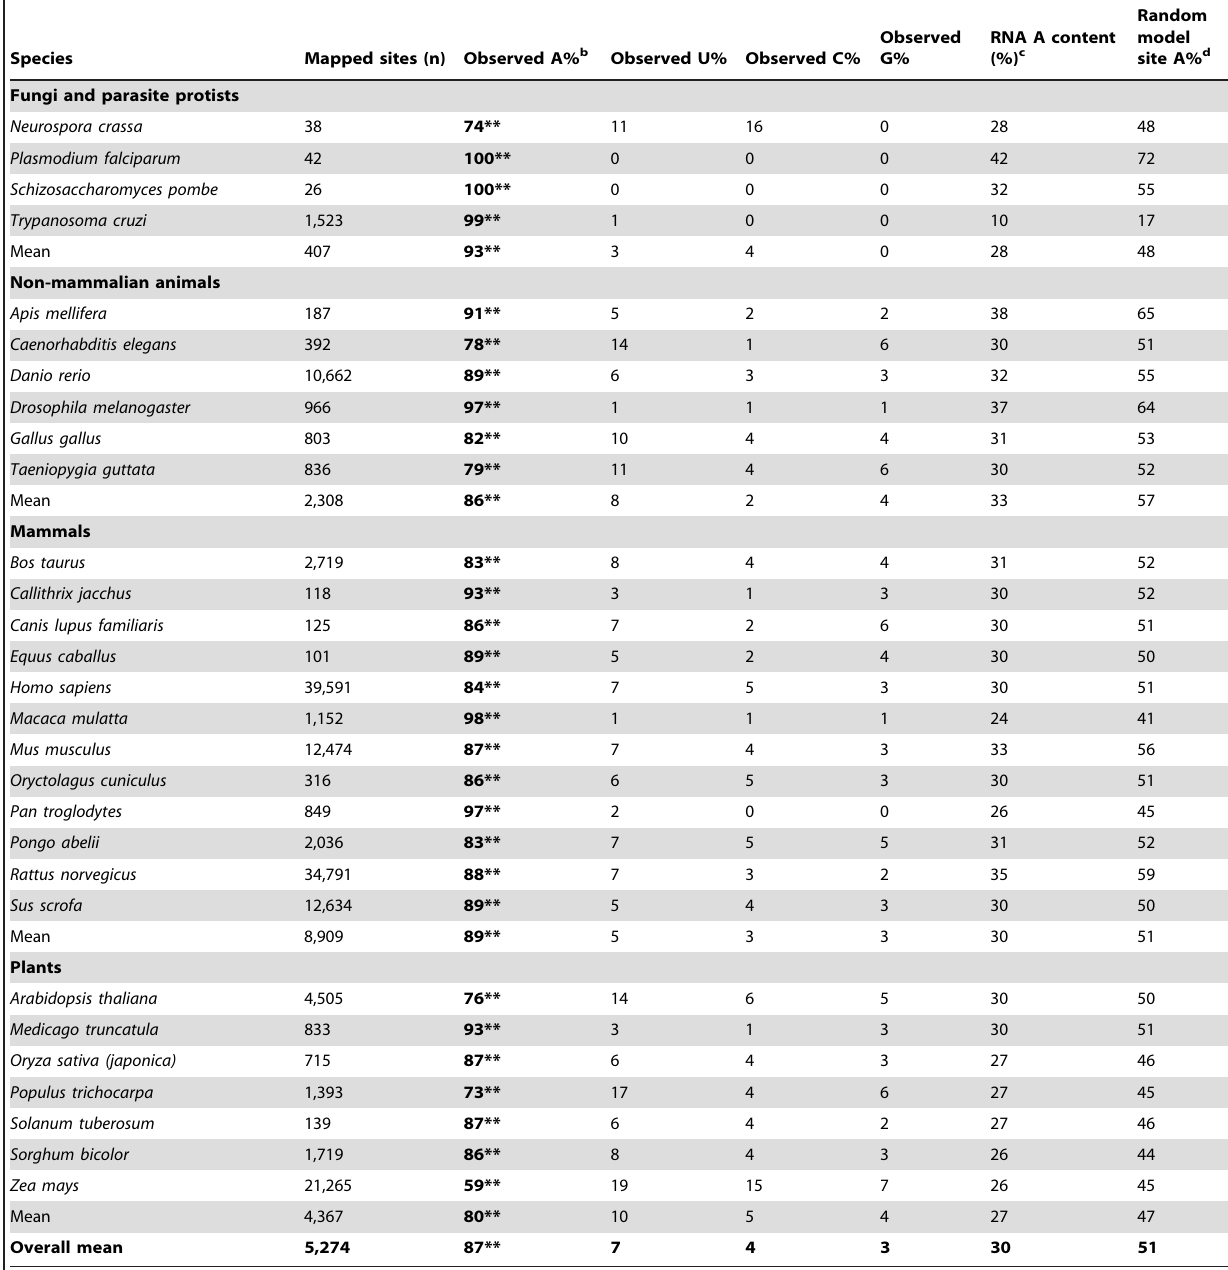
Table 3. Pre–messenger RNA nucleotide replaced by the polyadenylation [poly(A)] tail in different species a .